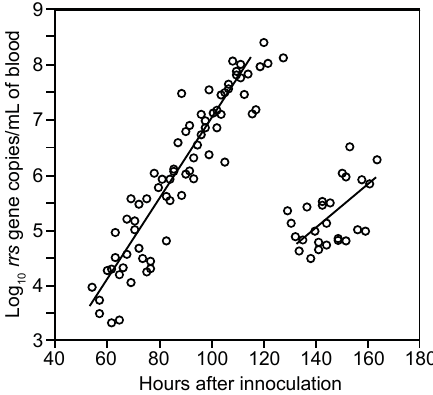
Figure 3. Proliferation and decline of B. hermsii HS1 cells in the blood of infected immunocompetent mice over time. The graph is a scatter plot of collected data on gene copies of 16S ribosomal RNA ( rrs ) of B. hermsii by qPCR ( y -axis) against time in hours ( x -axis) after inoculation of 95 BALB/c mice with serotype 7 of strain HS1. Samples were collected every 3 h beginning 12 h after inoculation; second samples were obtained from each mouse 7.5 h after the first. Each data point is a sampling from a single mouse. Linear regression determinations were made separately for hours 50–120 ( R 2 = 0.86) and >120.